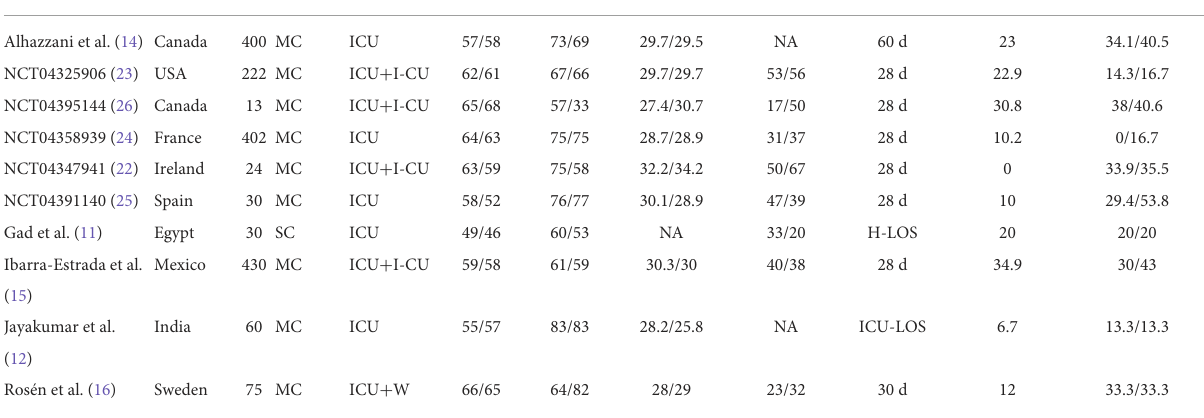
TABLE 1 Characteristics of included studies in the current meta-analysis and systemic review.